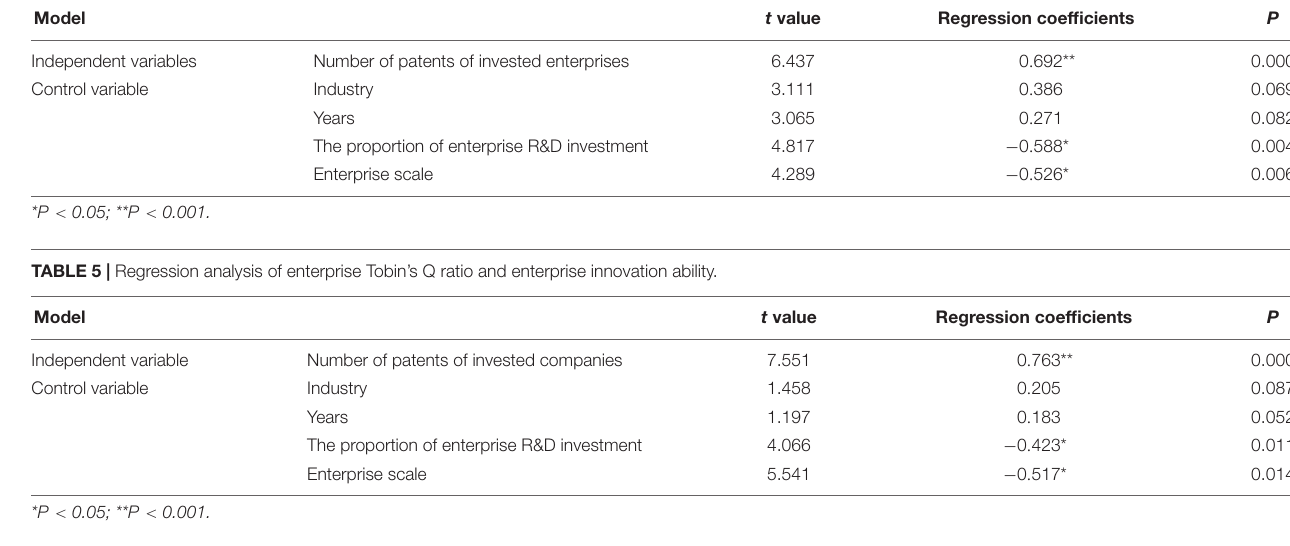
TABLE 4 | Regression analysis of return on equity and innovation ability of enterprises.